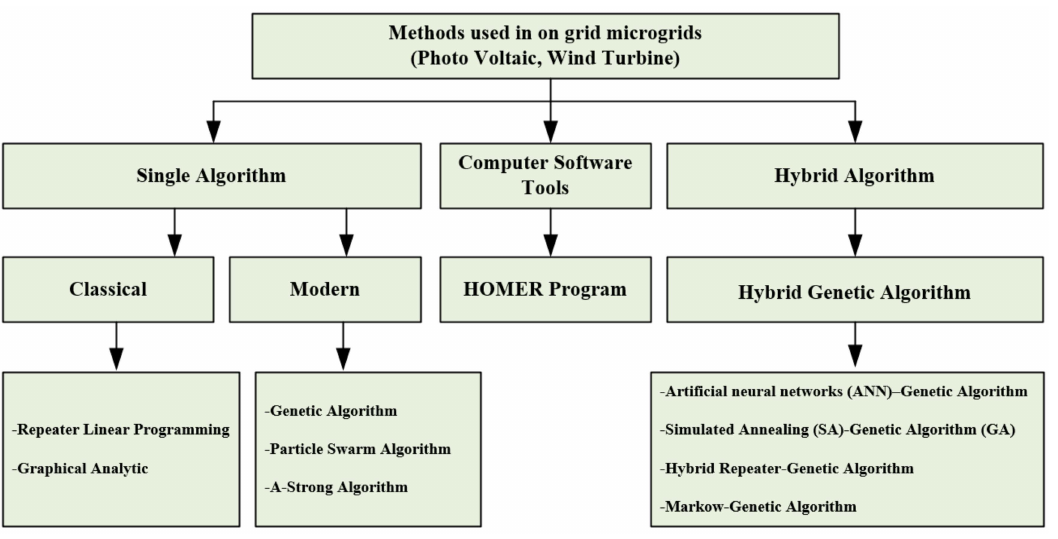
Figure 5. Methods employed in grid-connected